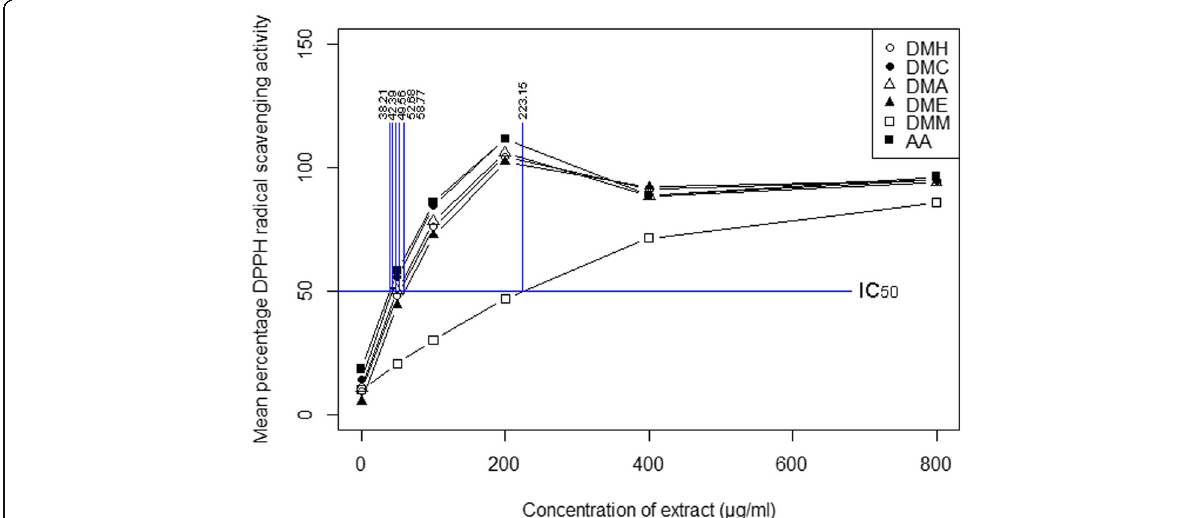
Fig. 2 Percentage of DPPH free-radical scavenging activity of crude extracts of D. moniliforme and ascorbic acid and their antioxidant capacities ( n = 3; p ≤